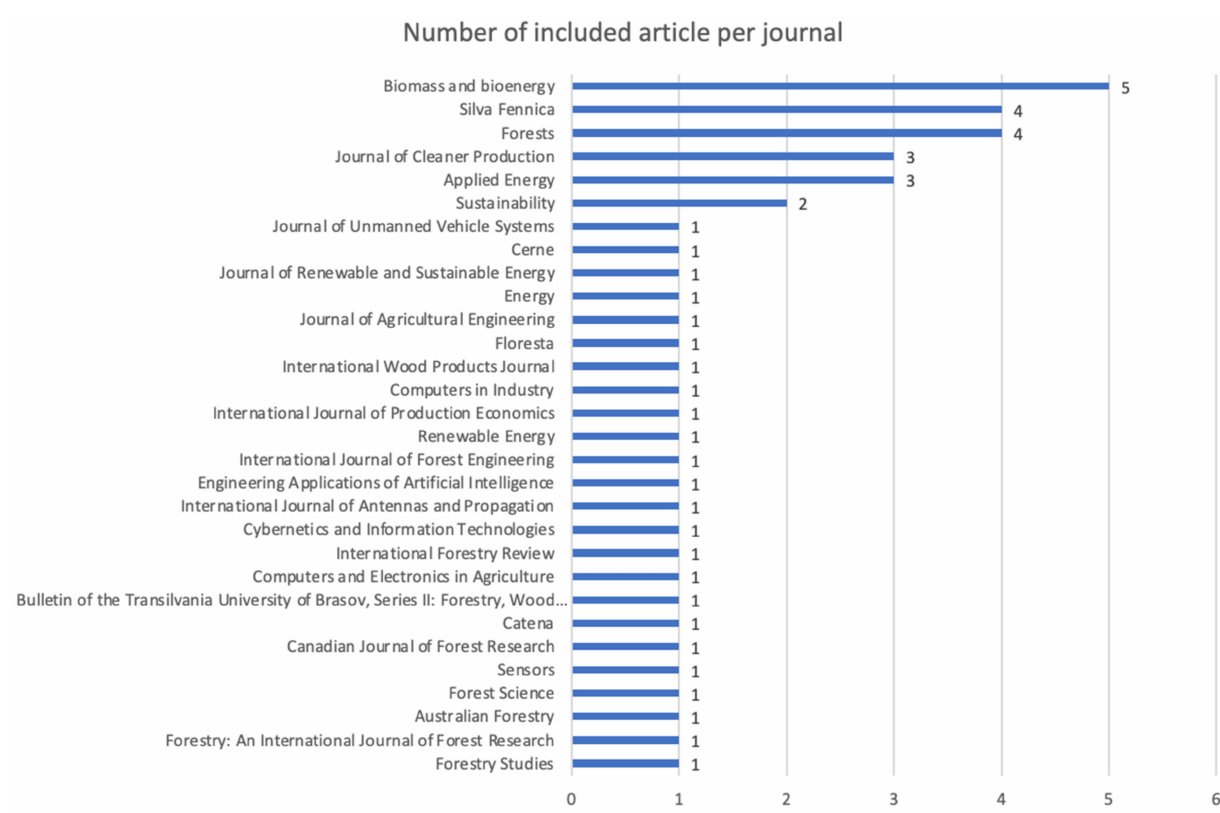
Figure 4. Summary of the selected articles sorted by